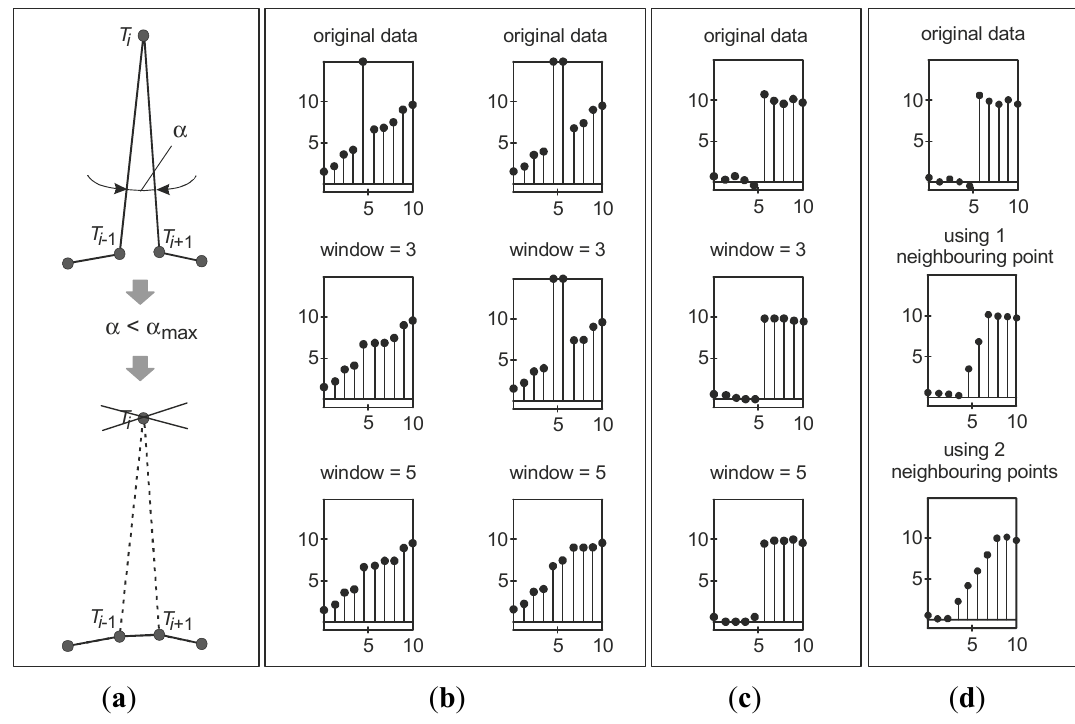
Figure 4. Principles and effects of methods for cross-sectional